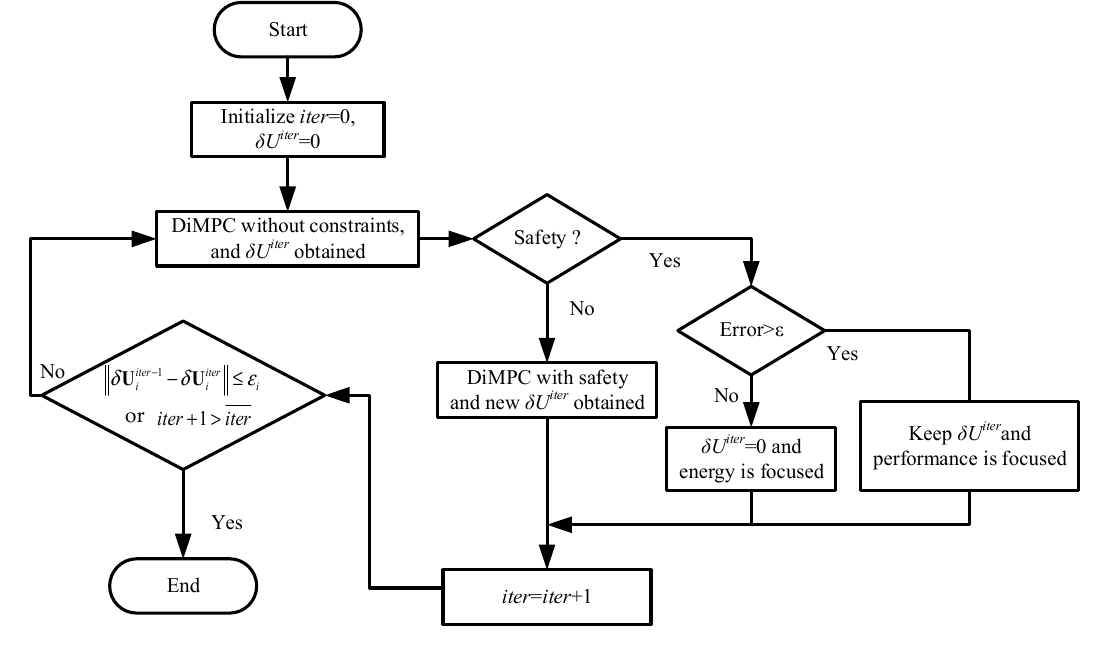
Figure 7. Flow chart for the MODiMPC.